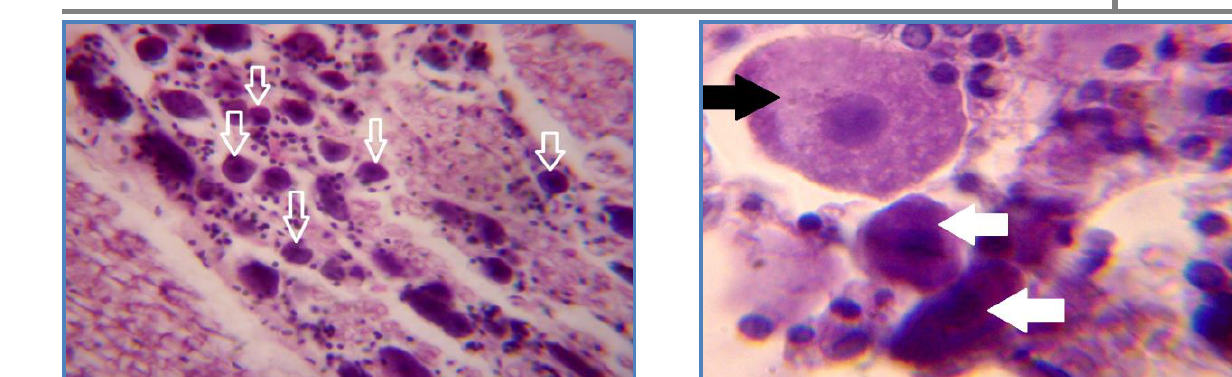
Figure, 3: Weaning group, L7. Sensory neurons, small and darkly stained (arrows) 40X.H and E.